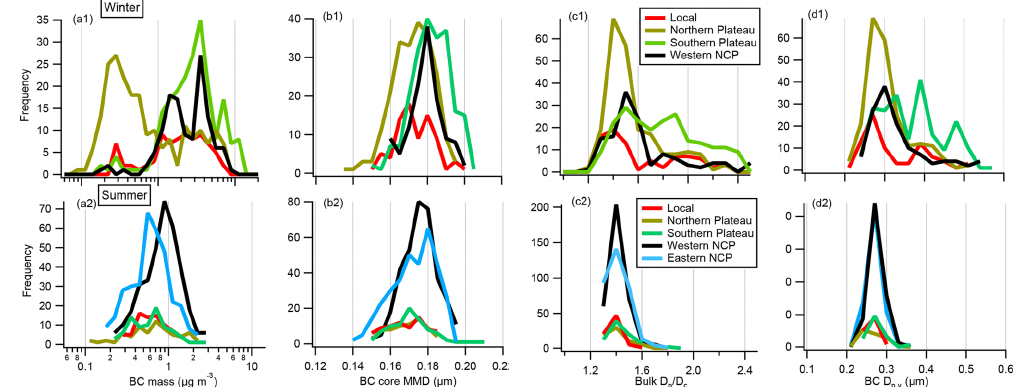
Figure 5. Histograms of BC mass loading, core size MMD, D p /D c and D p , v for different air masses in both seasons.